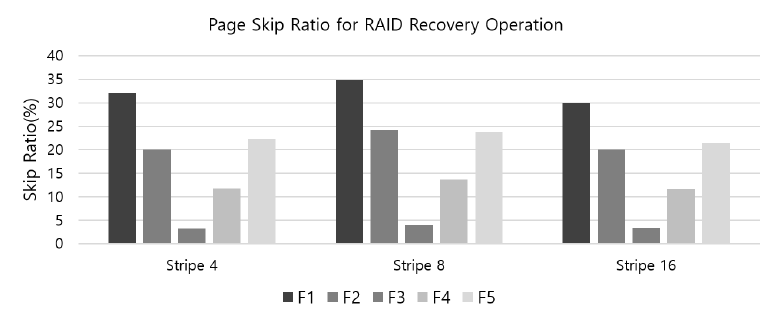
Figure 11. The skip ratio of pages when restoring error-occurred page in the stripe in the RAID scattering